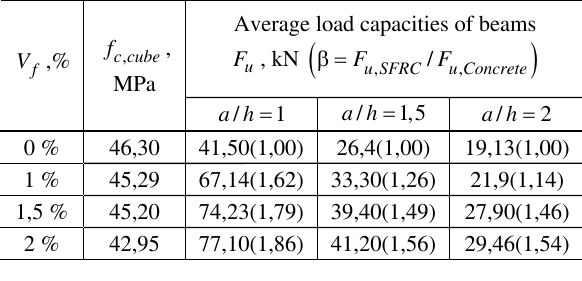
Table 1. Summary of test programme